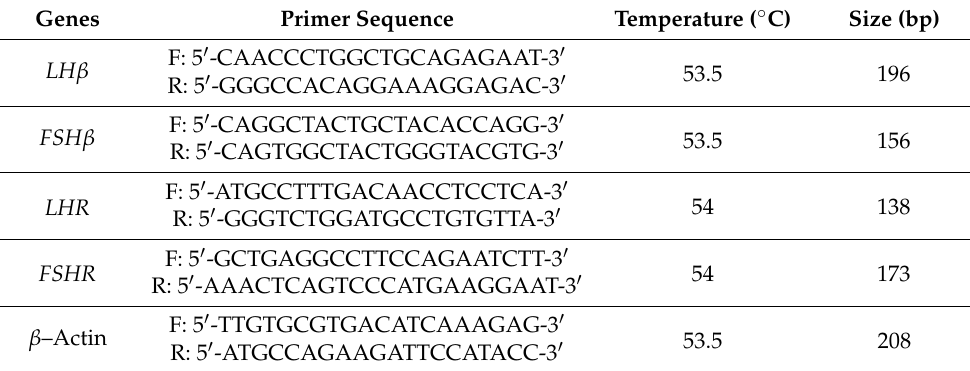
Table 1. Primer sequences of LH β , FSH β , LHR, and FSHR of plateau zokor ( Eospalax baileyi ) for the investigation of the expression of gonadotropin in the pituitary and